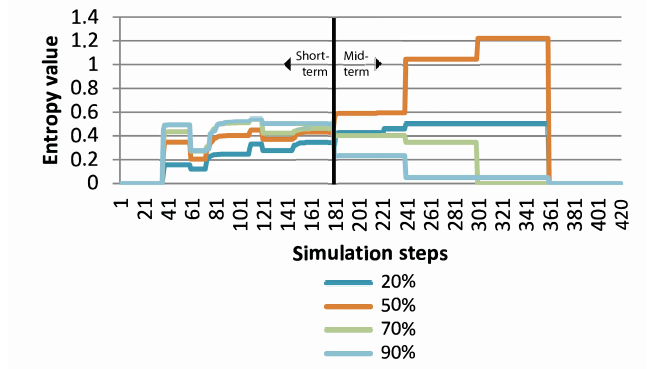
Figure 8. ACO results applying severe SAWs of